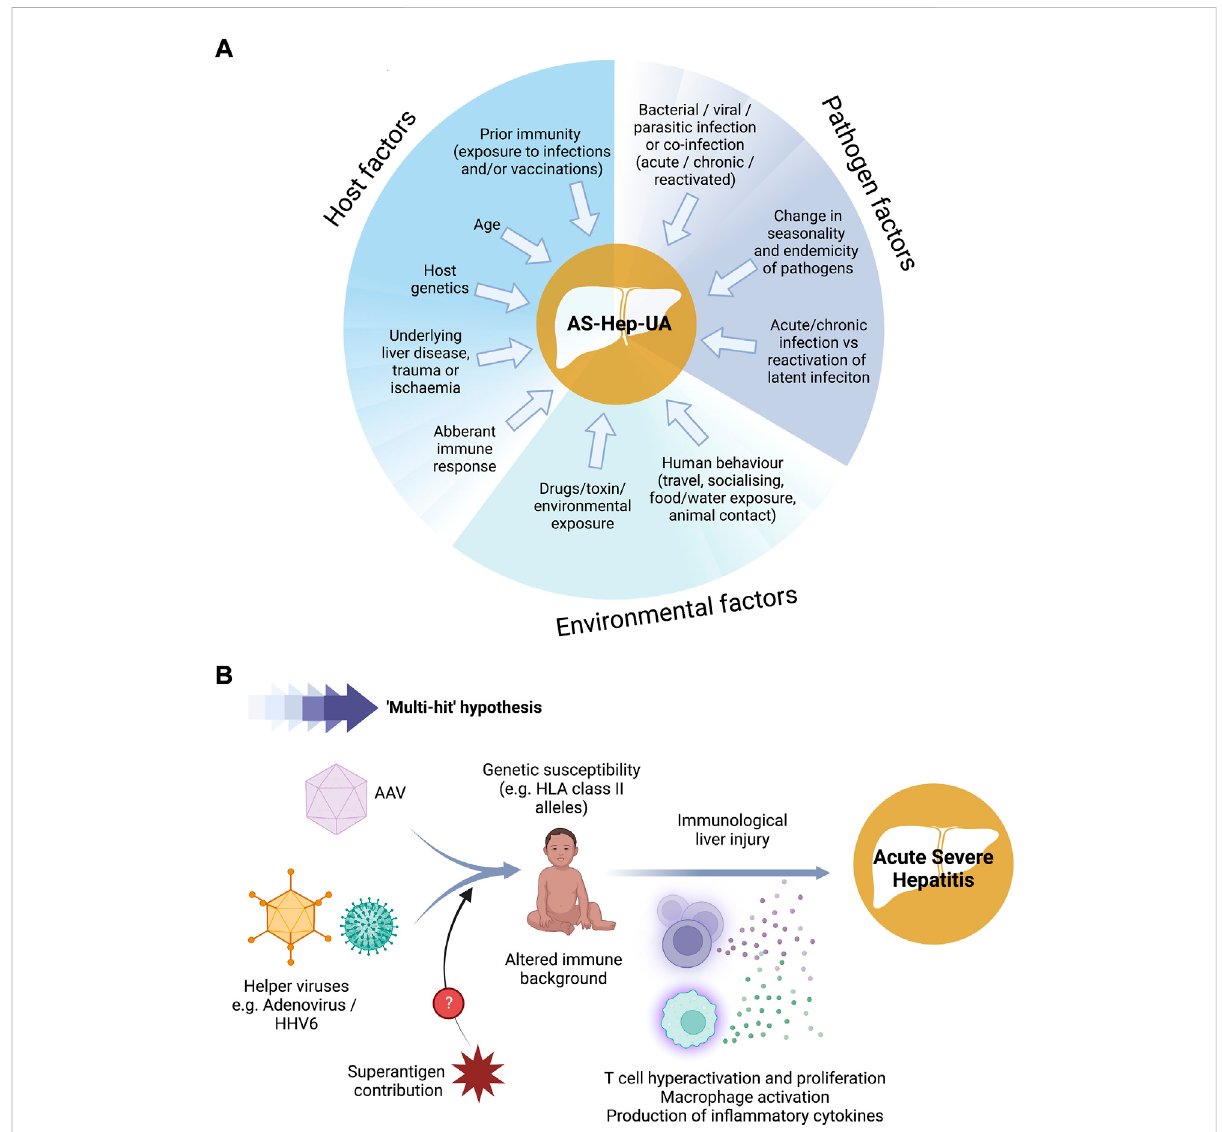
6. Figure created using BioRender with a licence to